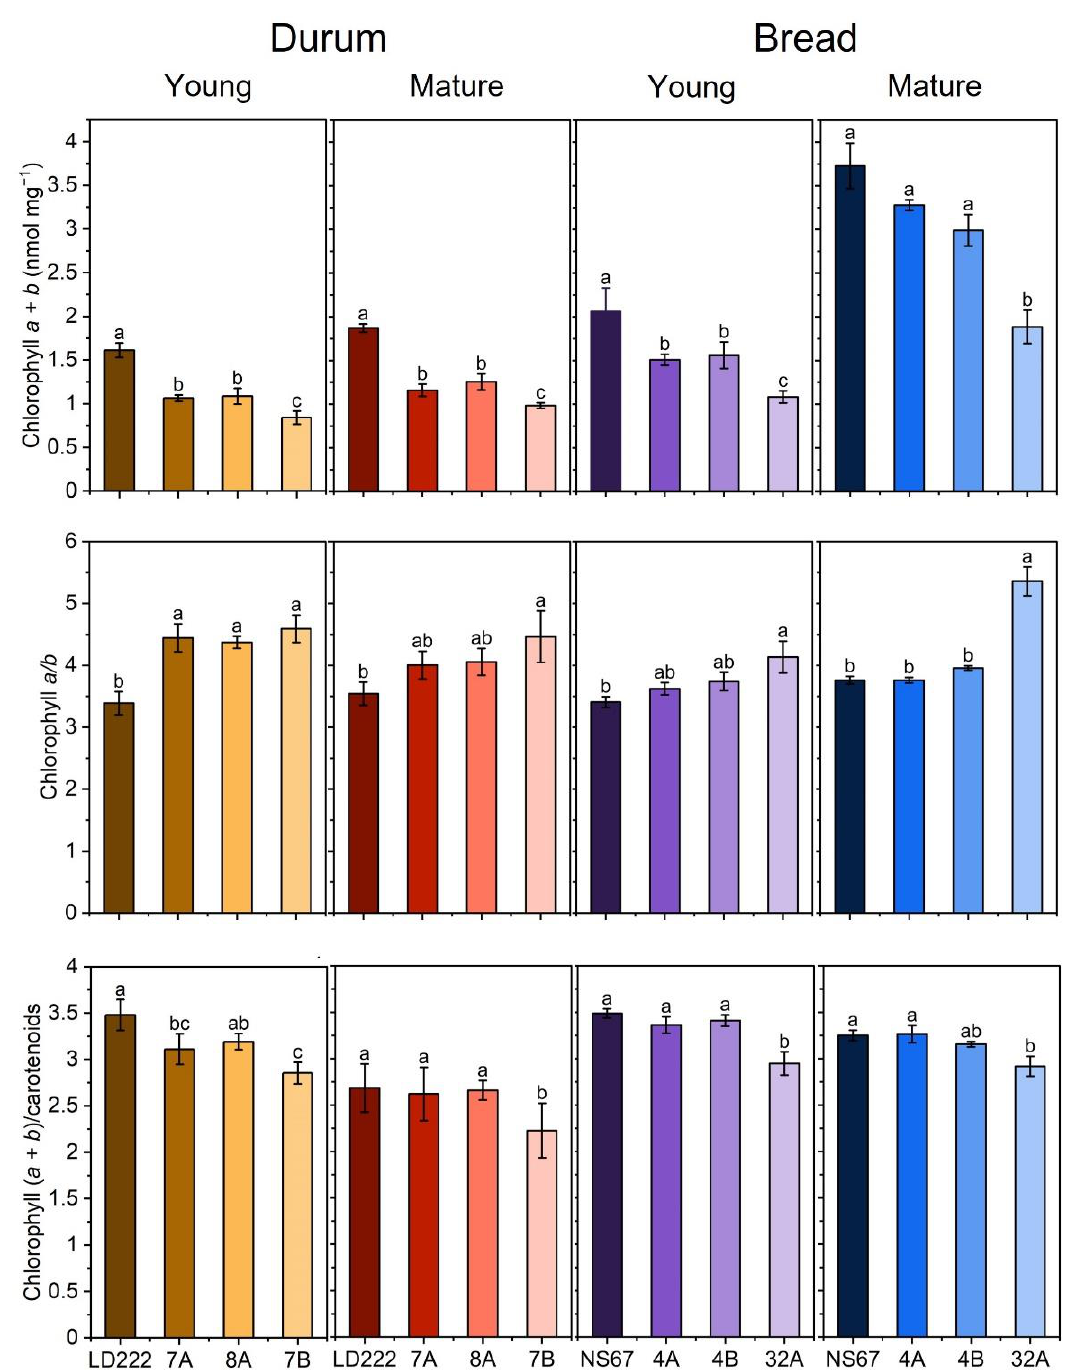
Figure 1. Photosynthetic-pigment quantification in leaves of young and mature plants of durum and bread wheat. Histograms represent average values ± Standard Deviation for n = 5 – 8; different letters indicate a significant difference at p < 0.05, as determined using one-factor ANOVA followed by Tukey ’ s test.